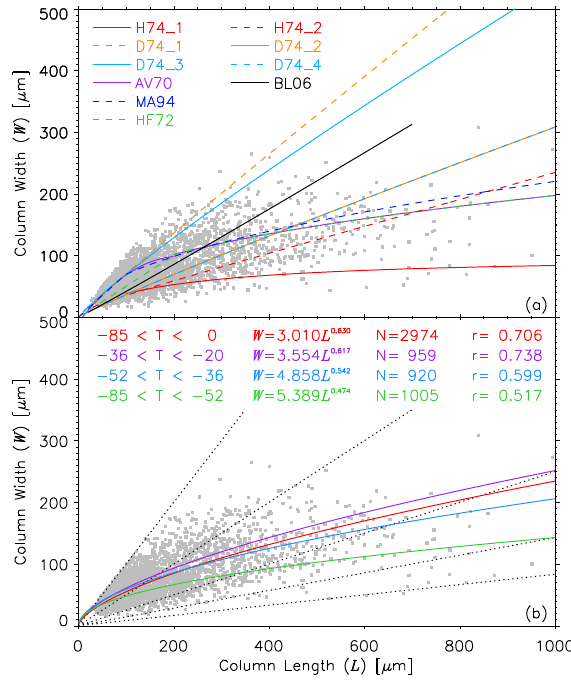
Figure 17. Comparisons between derived L – W relationships of horizontal orientation columns (HCOL) and those of previous stud- ies: AV70 (Auer and Veal, 1970), HF72 (Heymsfield, 1972), H74 (Hobbs et al., 1974), D74 (Davis, 1974), MA94 (Mitchell and Arnott, 1994), and BL06 (Baker and Lawson, 2006). Information on L – W relationships from previous studies is summarized in Ta- ble 1. L and W of horizontally oriented columns (HCOL) from this study are shown with gray squares in each panel. (a) L – W rela- tionships from previous studies and HCOL data. (b) Derived L – W relationships of columns using HCOL data as a function of temper- ature. Dotted lines representing L/W = 1, 2, 4, 7, and 12 are shown in (b)